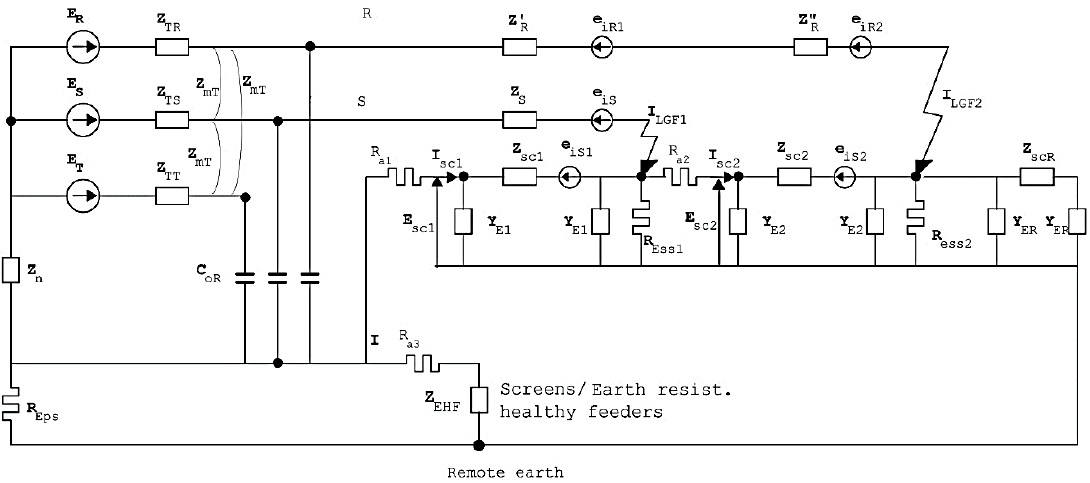
Figure 6. Equivalent circuit of a MV distribution network in case of a CCF occurring in the same cable line.